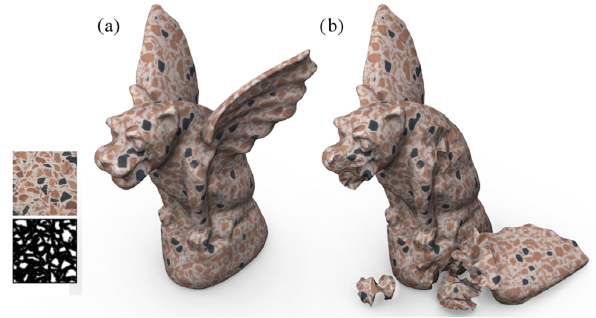
Fig. 15 Lazy solid texture synthesis [82] can be used to synthesize 3D texture from a 2D exemplar. This is done in a lazy manner, so that only voxels near the surface of a 3D model need be synthesized. Left: exemplar. Right: (a) a result for a 3D mesh, (b) a consistent texture can be generated even if the mesh is fractured. Reproduced with permission from Ref. [82], c (cid:13) The Author(s) Journal compilation 2008 c (cid:13) The Eurographics Association and Blackwell Publishing Ltd. 2008.